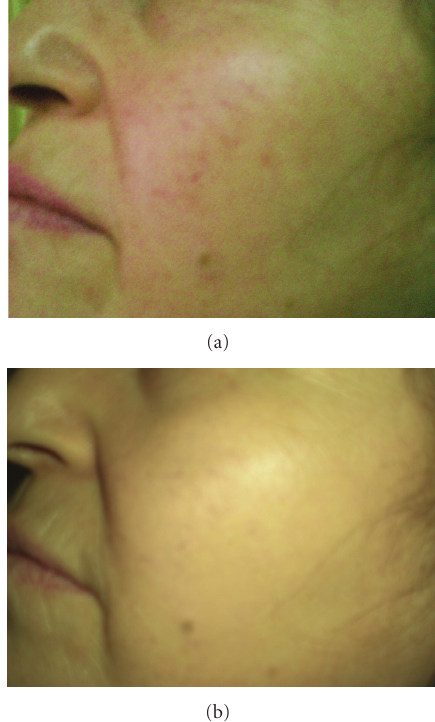
Figure 2: (a) Facial telangiectasia of a patient before treatment, (b) facial telangiectasia in the patient after fifth session of the treatment, Category-I (cleared